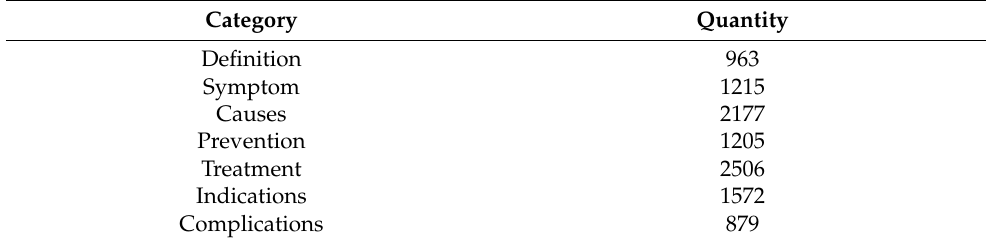
Table 1. Statistics of sample number of intent